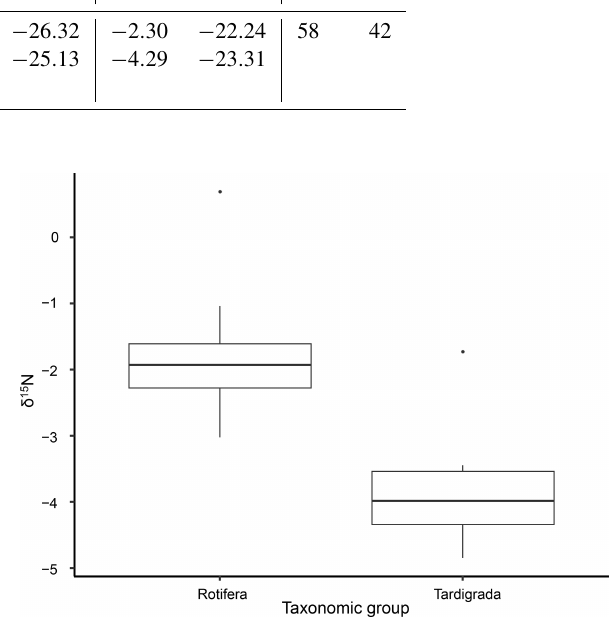
Figure 1. Differences in δ 15 N between tardigrades and rotifers analysed by Kruskal–Wallis rank sum test. The diagram displays medians and distribution of measured δ 15 N values. The whiskers represent the lowest and highest measured values. Both outliers rep- resent δ 15 N values of one replicate from